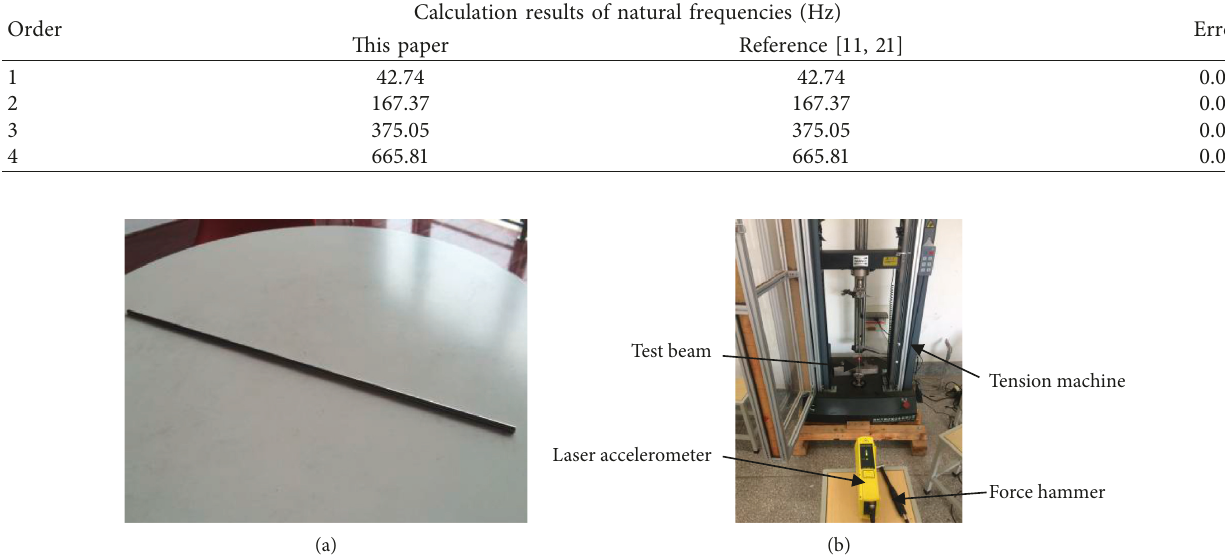
Figure 2: The natural frequency test of the prestressed beam. (a) The test beam. (b) The test Table 2: First-order natural frequency of the beam under different axial tensile forces. First-order natural frequency (Hz) Axial tensile force (N)